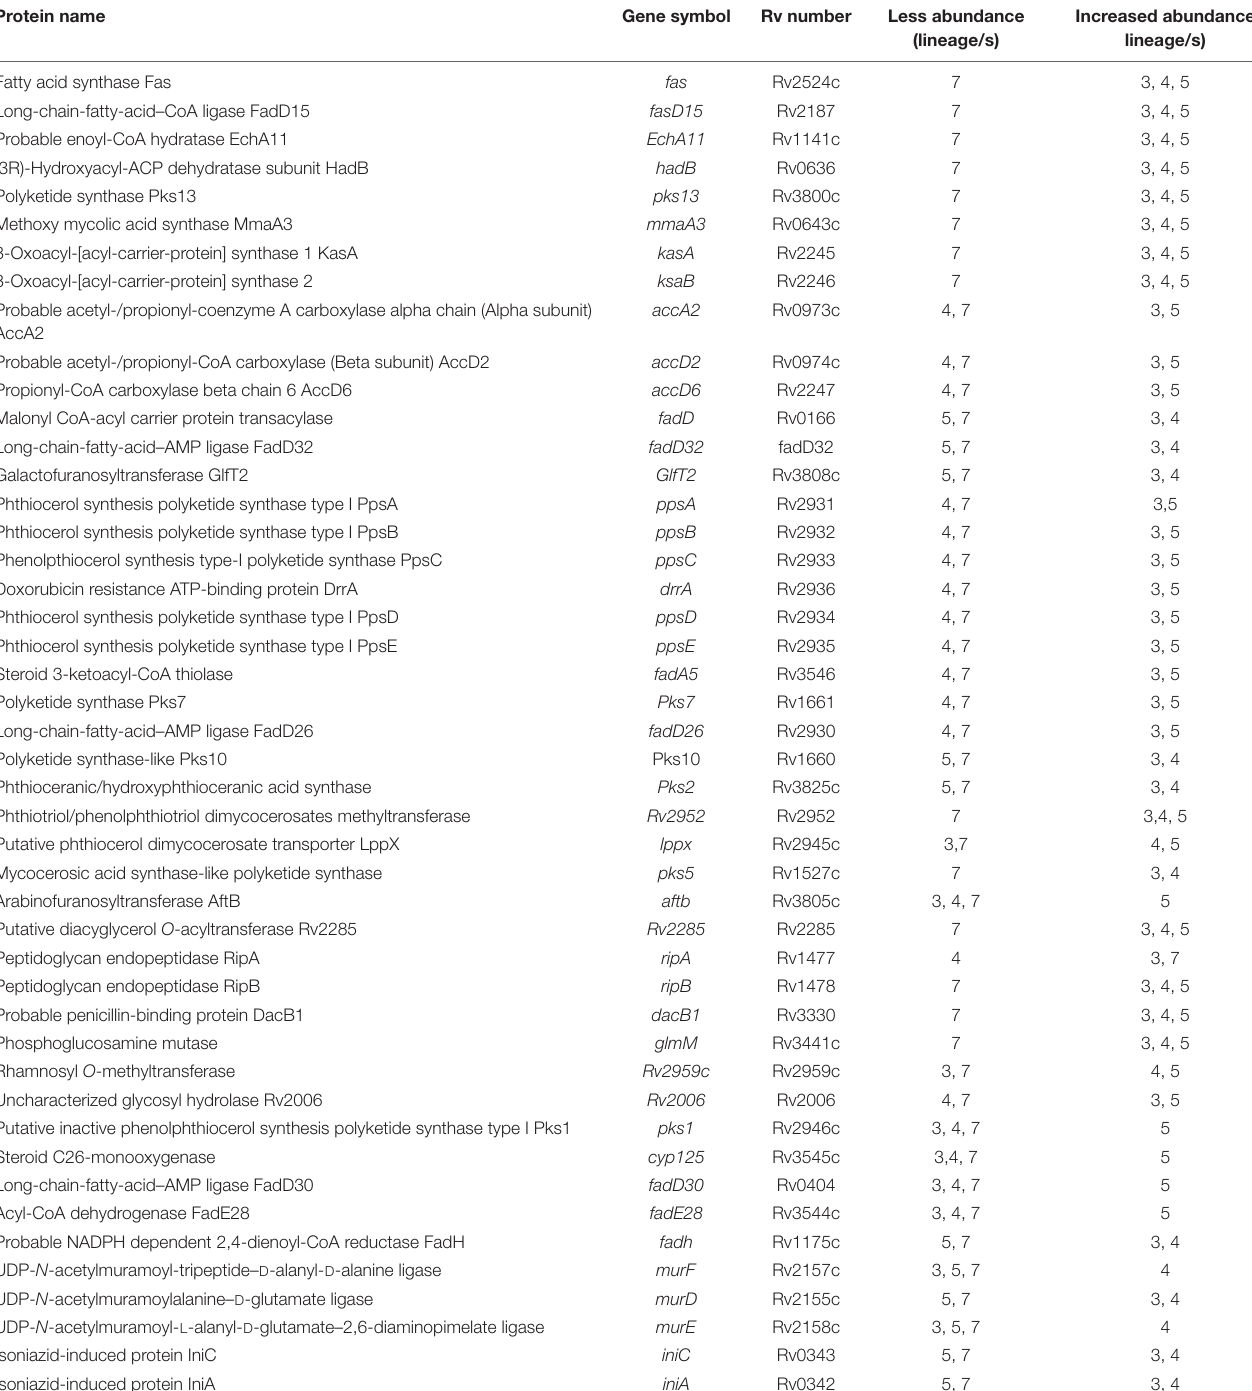
TABLE 4 | Differentially abundant proteins involved in lipid metabolism in MTBC